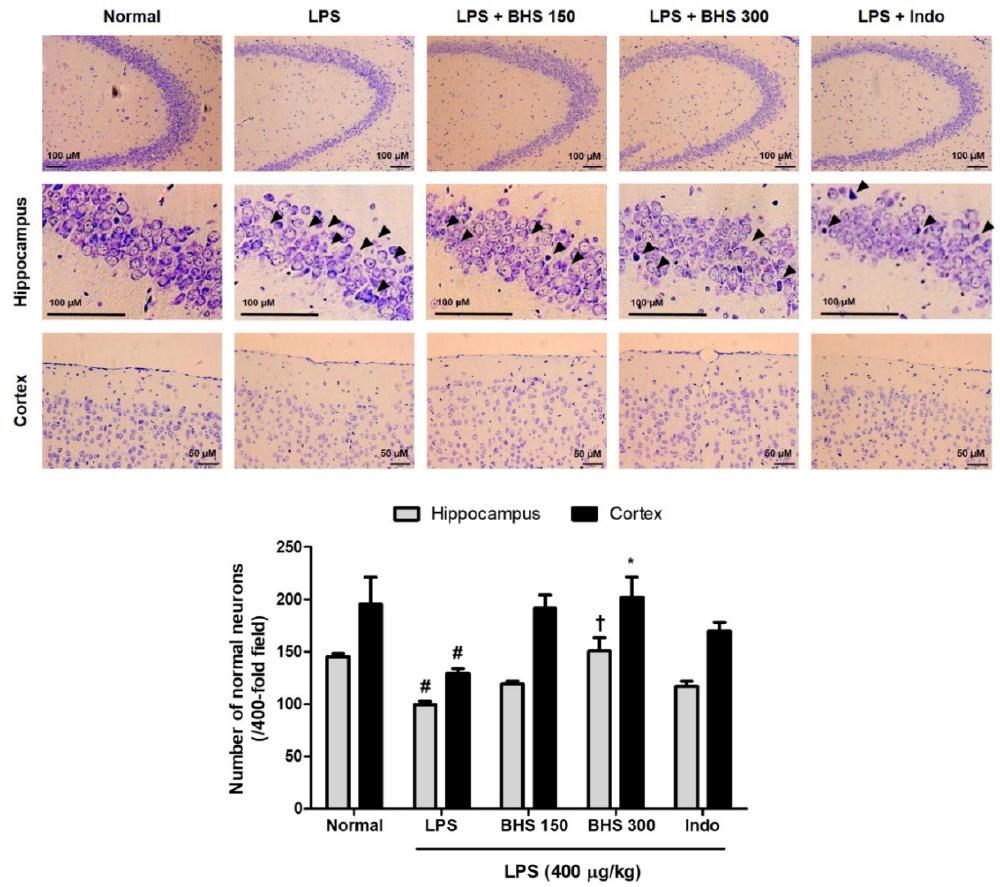
Figure 4. Effects of BHS on LPS-induced neuronal damage and histopathology in mice. Nissl staining images and the number of normal neurons in the hippocampus and cortex of each group of mice. Scale bars = 100 µ m for hippocampus and 50 µ m for cortex. Data represent mean ± SEM. Significant differences compared with the Normal group are indicated by # p < 0.05. Significant differences compared with the LPS group are indicated by * p < 0.05 and † p < 0.0001. BHS, banhasasim-tang (at 150 or 300 mg / kg per day); Indo, indomethacin; LPS, lipopolysaccharide.